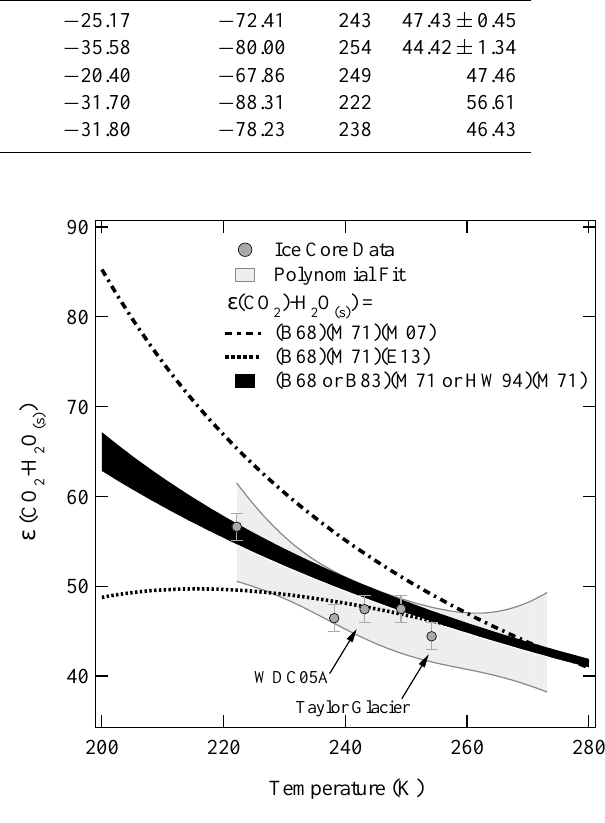
Figure 8. Temperature dependence of oxygen isotope fractiona- tion: the relationship between ice core δ 18 O-CO 2 gas fractionation ε (CO 2 -H 2 O ( s ) ) (grey circles) from this study (indicated with ar- rows) and Siegenthaler et al. (1988). The light-grey shading indi- cates a third-order polynomial fit to the data. The curves indicated the predicated fraction in thermodynamic equilibrium of gaseous CO 2 with vapor, liquid, and solid H 2 O (Eq. 1). The black band uses a range of determinations for α (CO 2 -H 2 O ( l ) ) and α (H 2 O ( l ) ) - H 2 O ( g ) ) but only M71 for α (H 2 O ( g ) ) -H 2 O ( s ) ) . The dot-dashed line uses only B68 for α (CO 2 -H 2 O ( l ) ) and M71 for α (H 2 O ( l ) ) -H 2 O ( g ) ) but M07 for α (H 2 O ( g ) ) -H 2 O ( s ) ) . The dotted line also uses only B68 for α (CO 2 -H 2 O ( l ) ) and M71 for α (H 2 O ( l ) ) -H 2 O ( g ) ) but E13 for α (H 2 O ( g ) ) -H 2 O ( s ) ) (see Table 4 for a description of the fractiona- tion